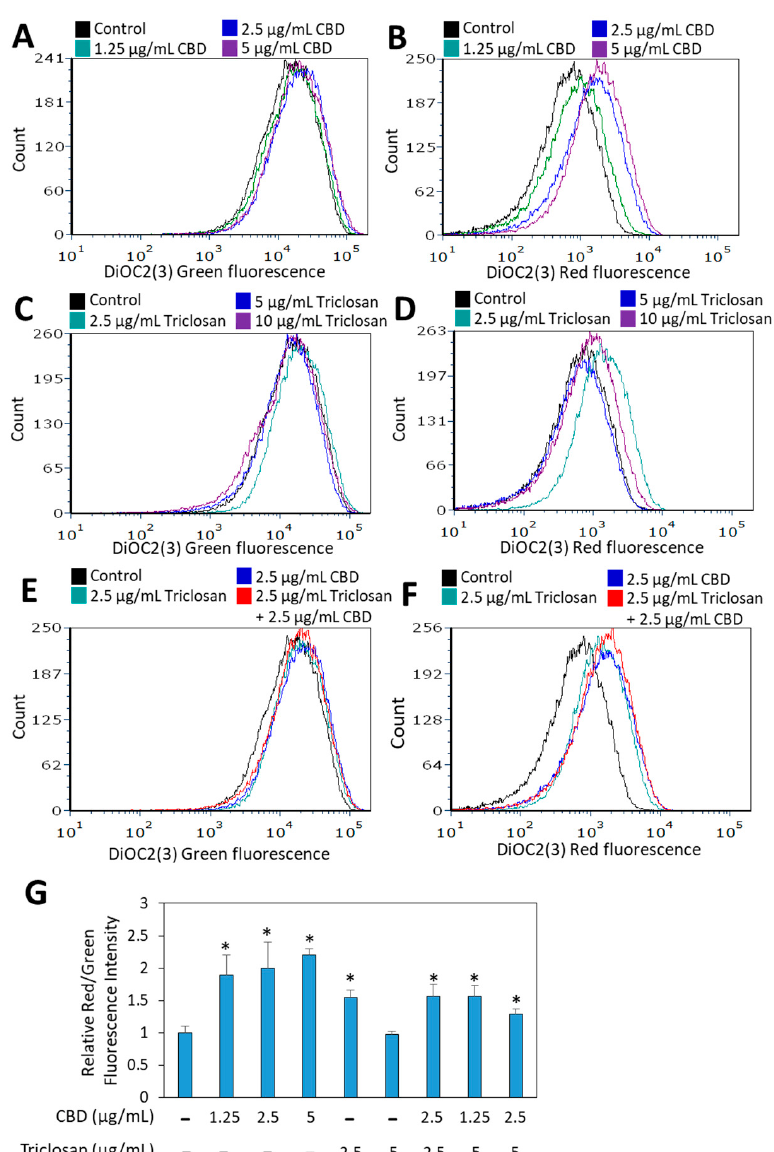
Figure 5. CBD and triclosan induced membrane hyperpolarization of S. mutans after a 1 h incubation. ( A – F ) Flow cytometry of DiOC2(3) green ( A , C , E ) and red ( B , D , F ) fluorescence intensities of S. mutans that was treated with the indicated concentrations of triclosan and CBD for 1 h. ( G ) The relative red/green fluorescence index of DiOC2(3) in the control and treated bacteria. An increase in this index indicates membrane hyperpolarization. * p < 0.05 compared to control bacteria. N = 3.